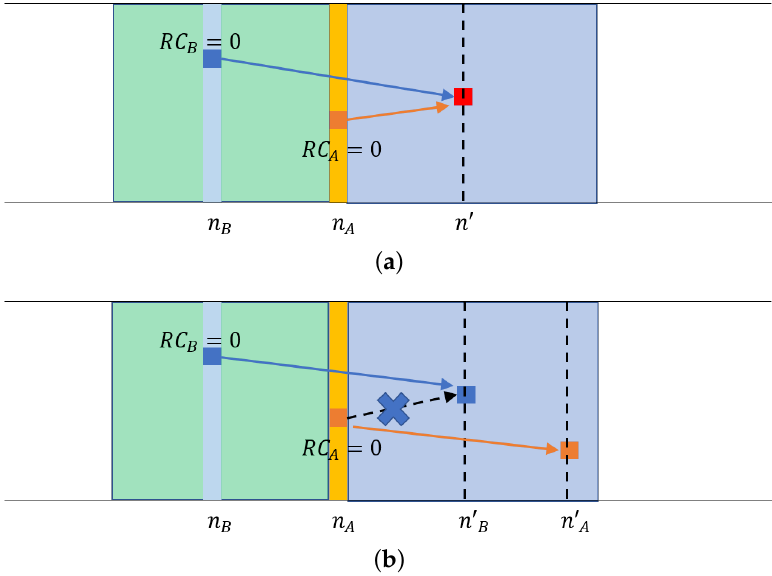
Figure 2. Use of the lookahead. ( a ) SPS cannot resolve the collision if two close UEs choose the same resource. ( b ) SPS/LA can resolve most potential collisions; A knows B ’s planned movement